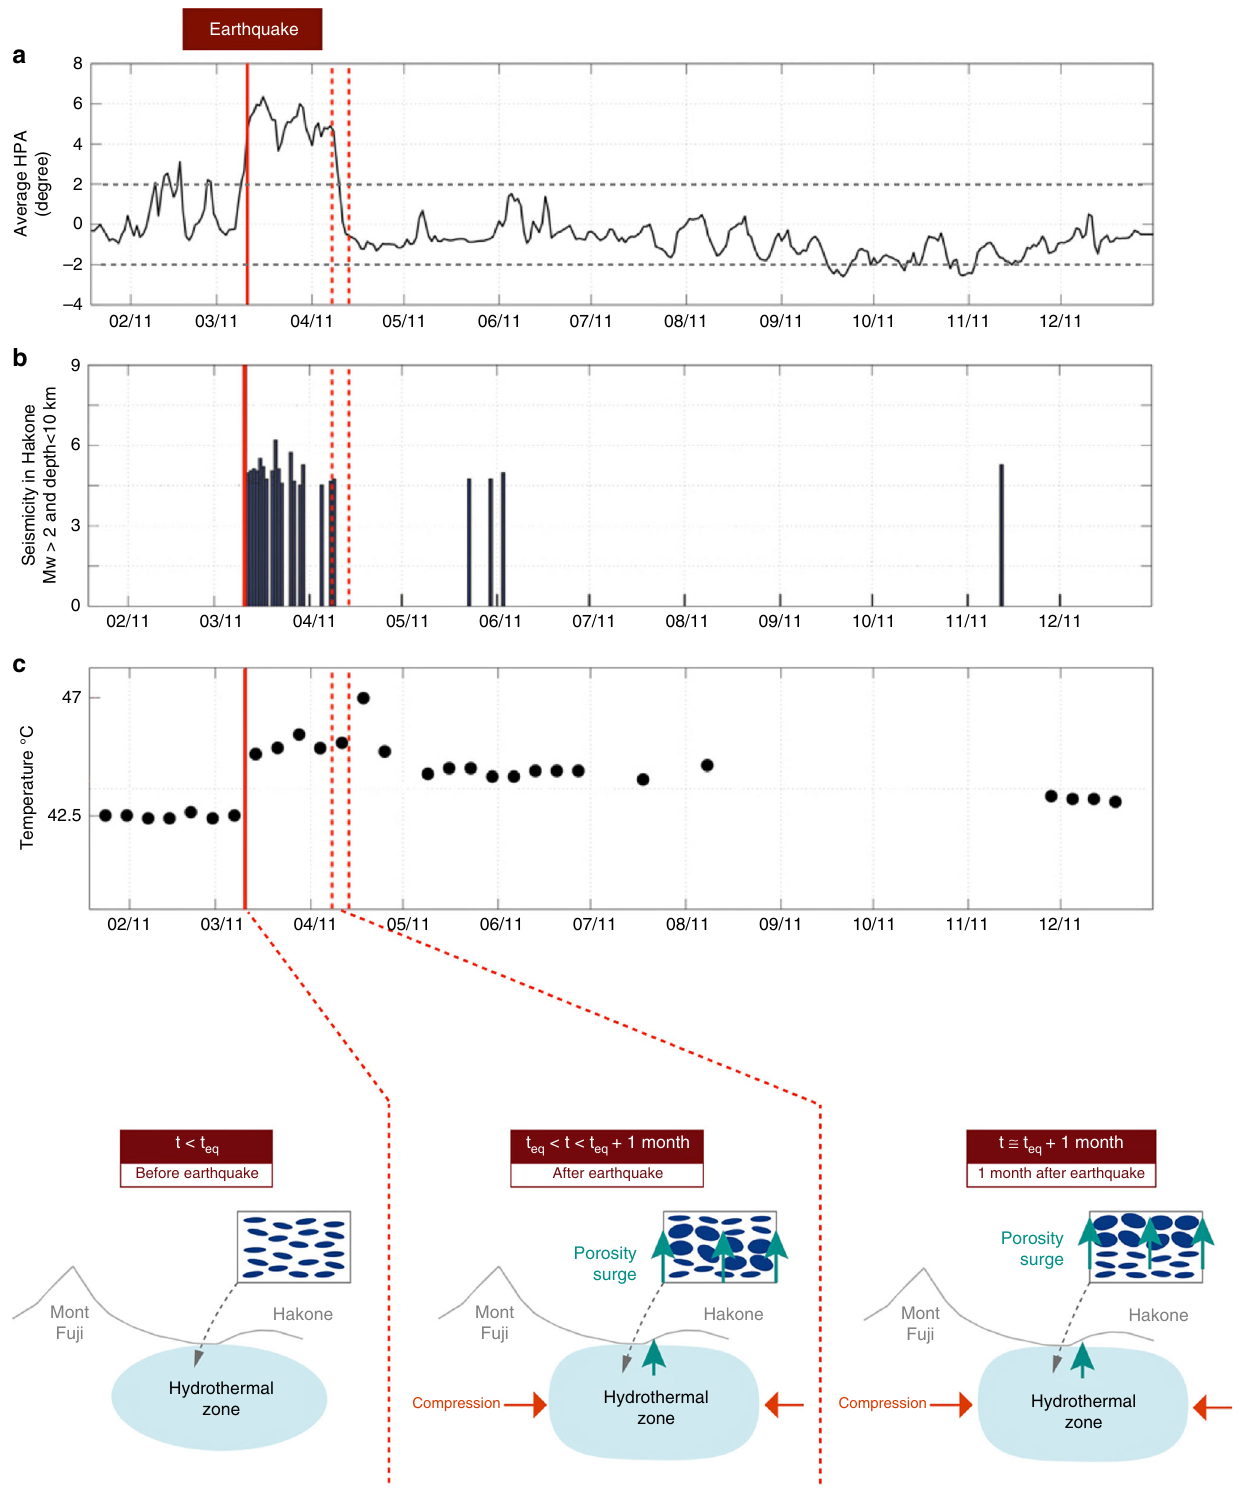
Fig. 2 Temporal changes and association with the porosity surge: a Averages of the absolute values of the horizontal polarization anomaly (HPA) for all of the processed receiver pairs and through the year 2011. Note that the temporal resolution is 7 days (i.e., length of the stacking window of the cross- correlations) and the error on the HPA is of the order of 2 (cid:1) . b Seismicity in the study area. Vertical lines represent earthquakes with magnitudes >2 and depths <10 km. c Changes in temperature of the hot spring waters at station A (Fig. 1) in the Hakone area. Vertical red line, time of the Tohoku-Oki earthquake. Bottom: Scheme representing the propagation of the porosity surge in the hydrothermal system (blue) between the area East of Mount Fuji and beneath Mount Hakone. Small blue ellipses, fi ssures in the medium fi lled with hydrothermal fl uids. The size of the ellipses increases during the passage of the hydrothermal fl uid